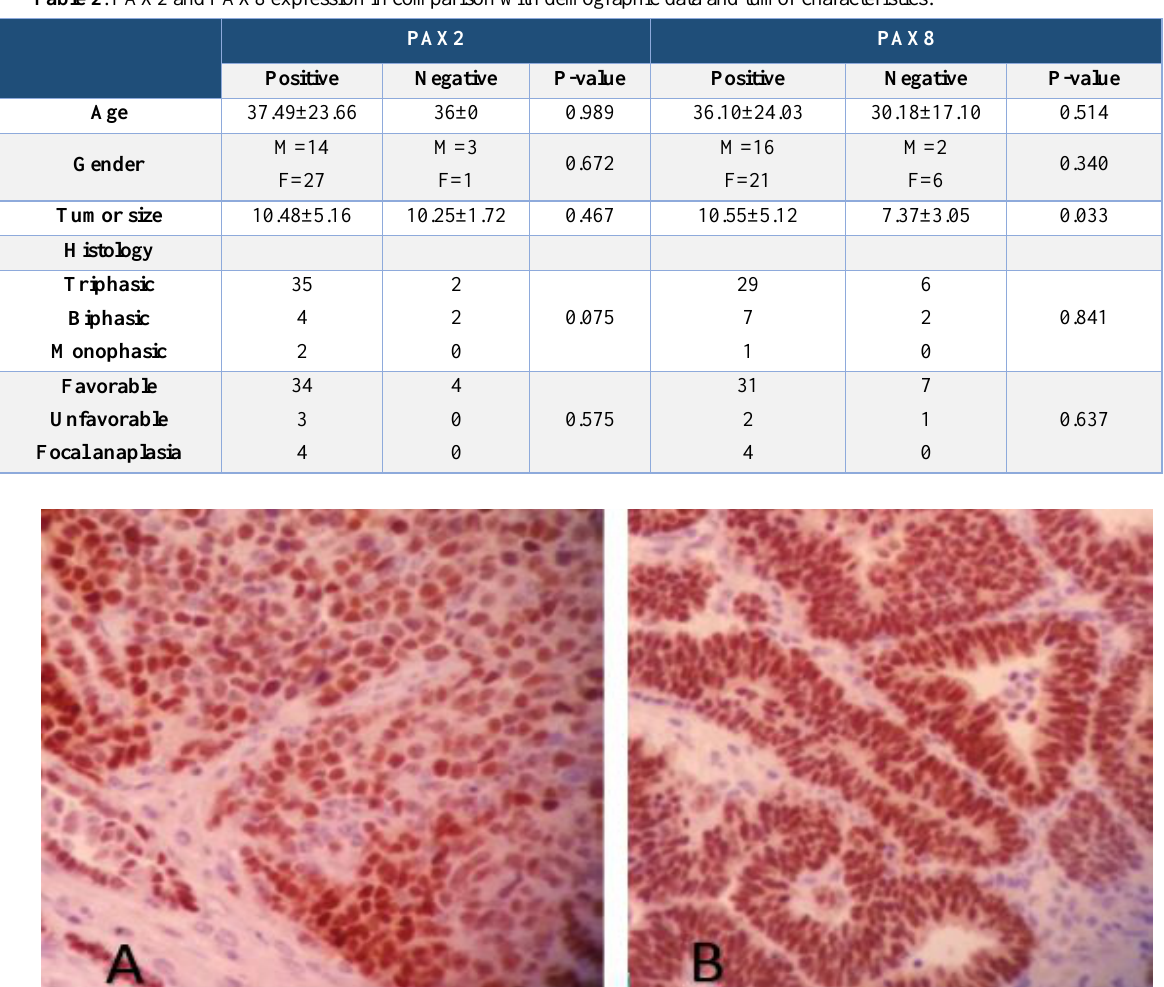
Fig. 1 . PAX2 immunostaining in: A) blastemal component and B) epithelial component